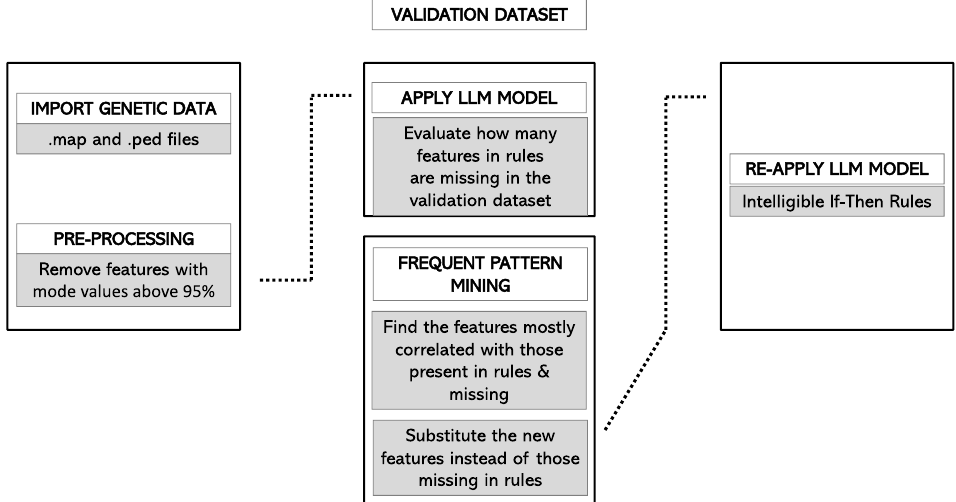
Figure 2. Forecast pipeline in the Rulex environment. Information is imported for the validation cohort. The LLM model is applied to the validation cohort. The conditions that are missing in the validation cohort are analyzed, and a dedicated association mining algorithm operates to find in the training cohort new features that are present in the validation cohort and are correlated (at a predefined threshold) to the missing conditions. The LLM model is then re-run in the validation cohort, and metrics of accuracy are calculated. Abbreviations: LLM, Logic Learning